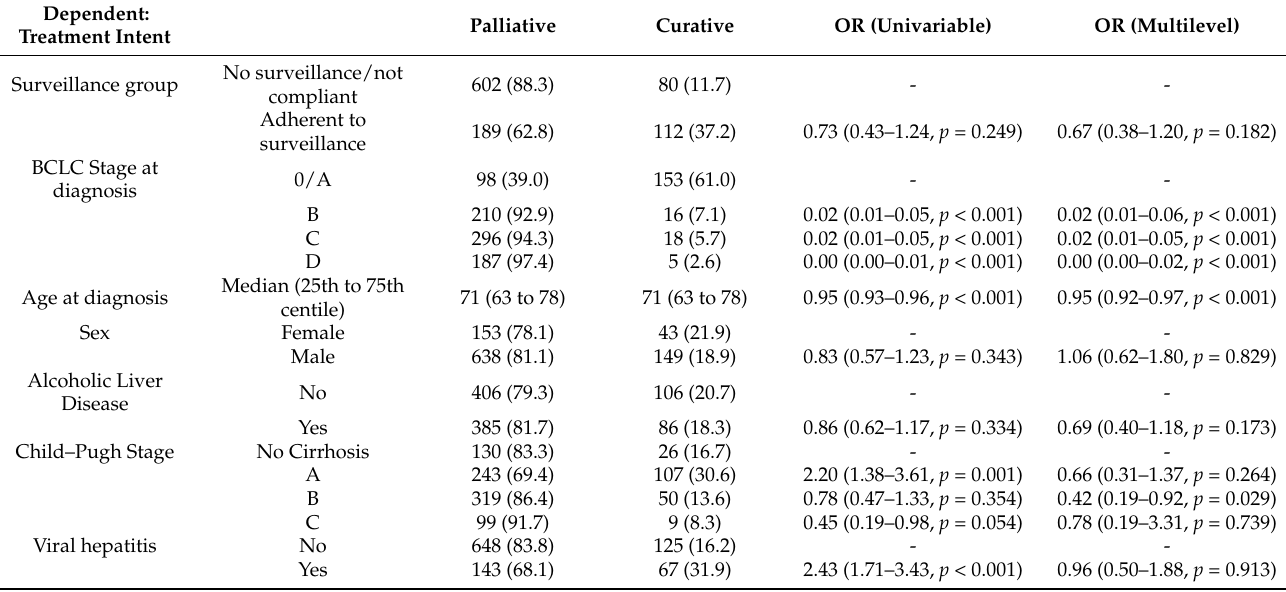
Table 4. Model for receiving potentially curative